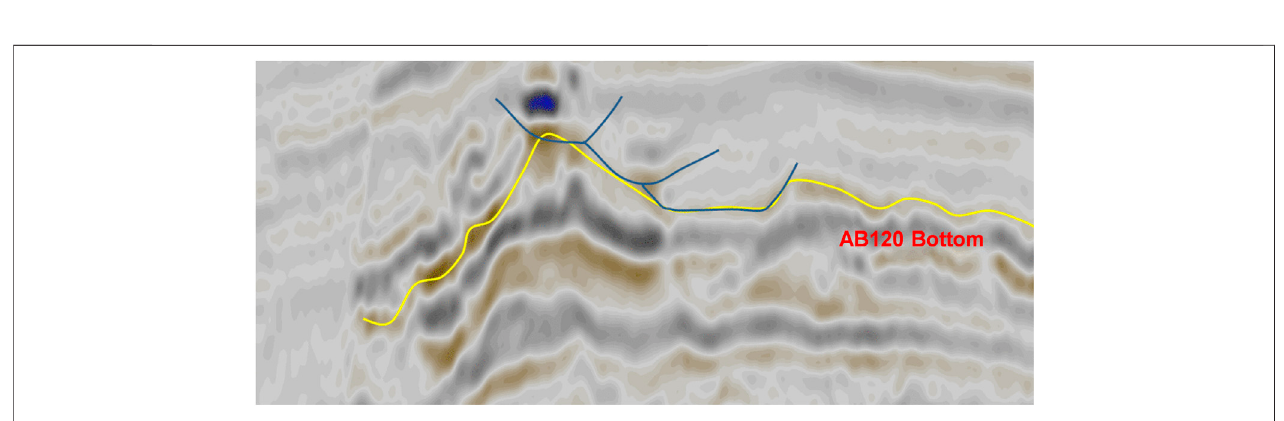
FIGURE 3 | Seismic response characteristics of the muddy